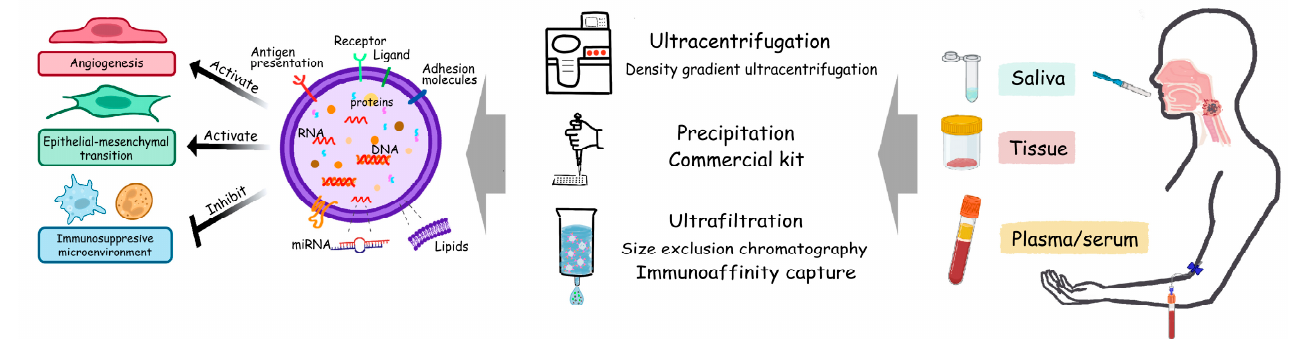
Figure 2. EV cargoes and the clinical application of EV-miRNA during HNSCC diagnosis and treatment processes. The exact influences caused by EVs depend on their cargoes. Oncogenic EVs activate the vasculature, promote epithelial–mesenchymal transition, facilitate formation of pre-metastatic niche, protect tumor cells from immune supervision and realize many other functions. Based on current technologies, EVs could be detected and extracted from saliva, blood, urine and tissue samples. Much evidence supports the great significance of EV-miRNAs in the diagnosis, progression, prognosis prediction and treatment evaluation of HNSCC. The miRNAs shown in bold (e.g., BART7-3p) are EBV-derived.